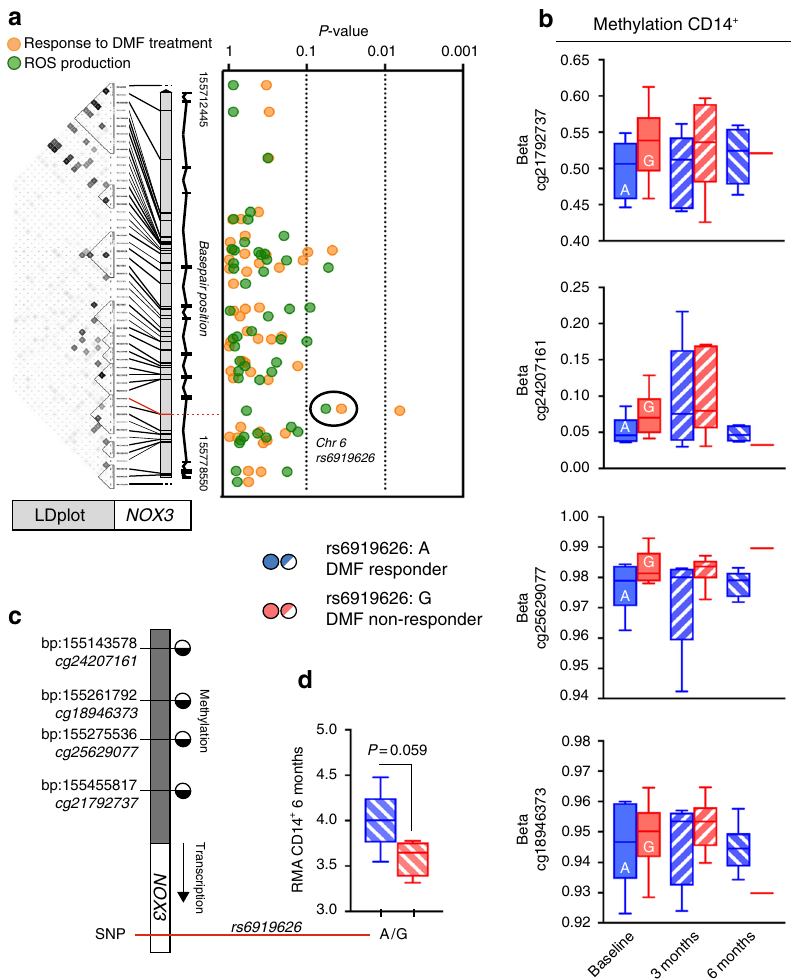
Fig. 4 Genetic association with SNPs in NOX3 to ROS generation and response to DMF treatment. a The G allele of rs6919626 ( red line ) was suggestively associated with reduced ROS generation in monocytes after ex vivo stimulation with E. coli ( P = 0.057, β = − 0.28) and signi fi cantly associated with lack of response to DMF treatment ( P = 0.036, OR = 1.57). The Linkage Disequilibrium (LDplot) of the markers in NOX3 was generated with HaploView4.2 in the Swedish population. Darker gray indicates higher r2 between markers. b Methylation in four CpGs in the NOX3 promotor region over time and between responders ( A allele) and non-responders ( G allele) (Baseline: n = 6 + 6, three months: n = 5 + 6, six months: n = 6 + 1). c Schematic illustration indicating methylated or unmethylated CpGs in the NOX3 promotor region. d NOX3 transcription in responders and non-responders at six months following DMF ( n = 5 + 4). Analysis performed using Welch ’ s two-tailed t test. Graph ( b , d ) shows box-and-whisker plots indicating values outside the 5 – 95 percentile are indicated